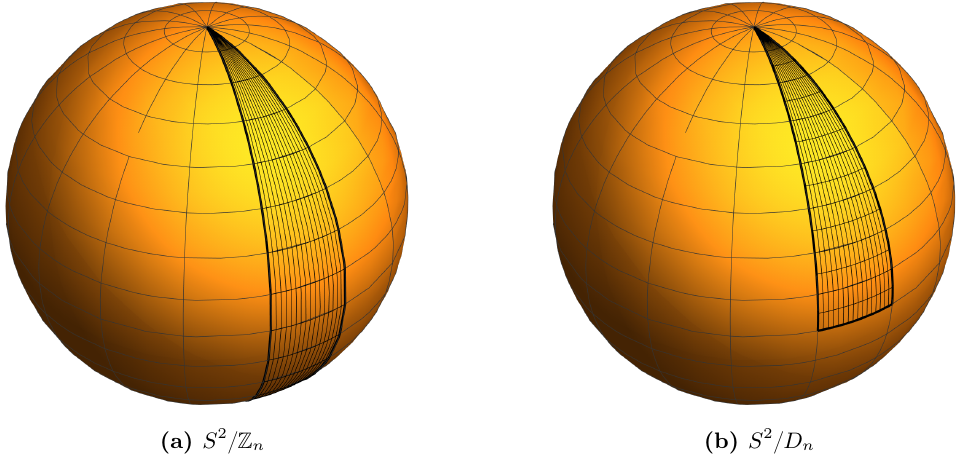
Figure 1. The fundamental domains of the S 2 { Z n and S 2 { D n orbifolds, depicted as the shaded regions of the sphere in (1a) and (1b)